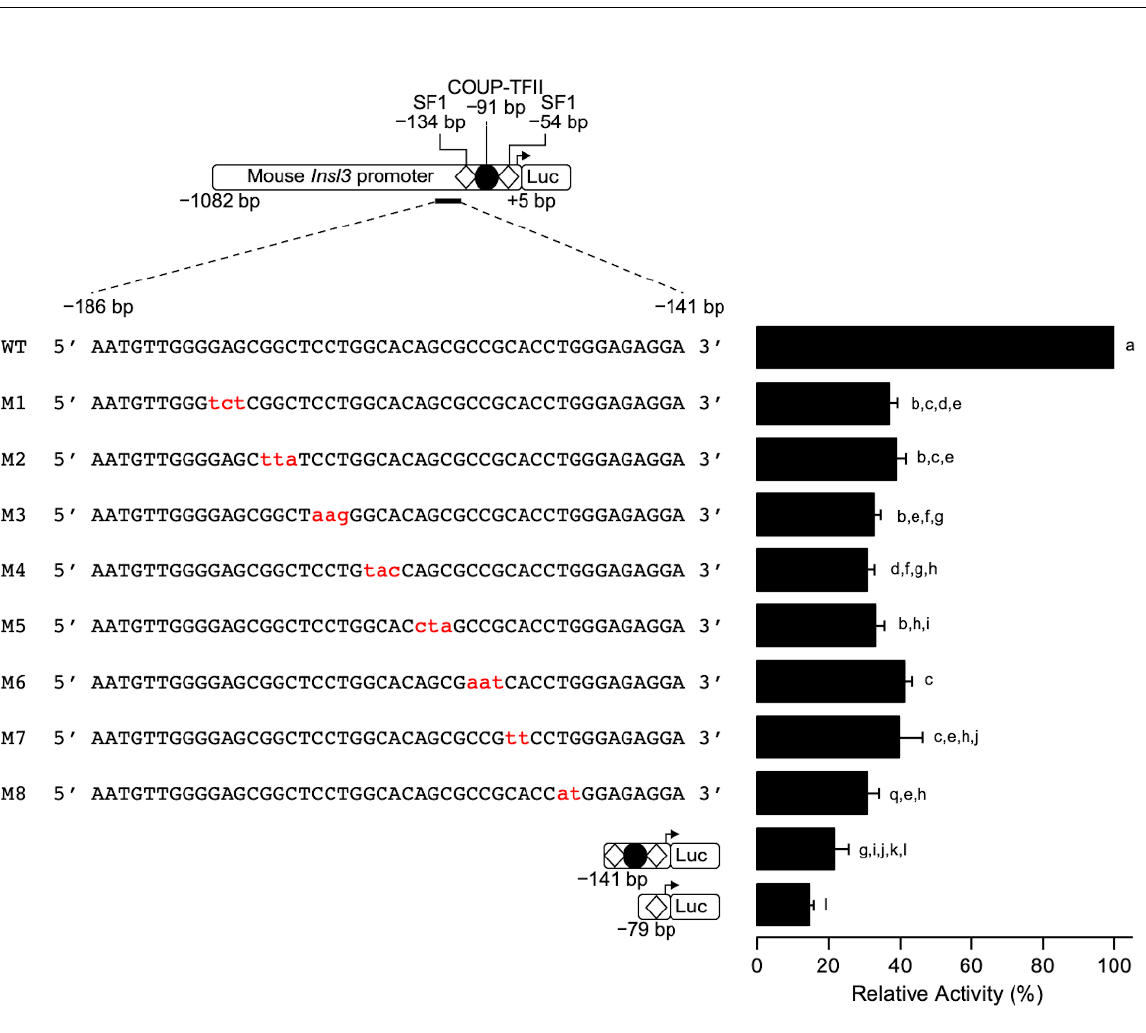
Figure 3. Fine mapping of the 35-bp region in the proximal mouse Insl3 promoter. MA-10 Leydig cells were transfected with various − 1132 bp mouse Insl3 promoter constructs: a wild-type promoter and a series of trinucleotide or dinucleotide mutated constructs (M1 to M8; the mutations are in red lowercase). The position of previously identified binding sites for SF1 (white diamonds) and COUP-TFII (black circle) is indicated. Results are shown as % Relative Activity ( ± SEM) relative to the activity of the − 1132 bp wild-type reporter, which was set to 100%. Different letters indicate a statistically significant difference between groups ( p < 0.05).